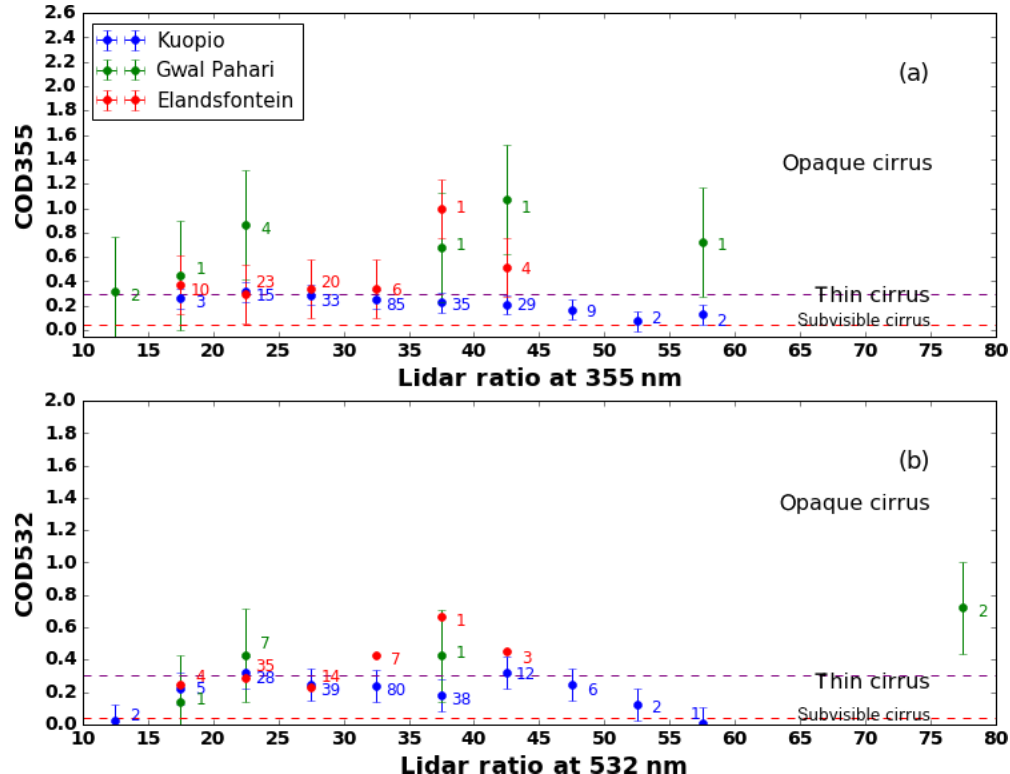
Figure 6. Dependence of the lidar ratio on COD at 355nm (a) and the lidar ratio with COD at 532nm (b) . Numbers labelled indicate the number of cases per lidar ratio bin. Horizontal dashed lines: cirrus categories by Sassen and Cho (1992). Table 4. Predominant aerosol type and AOD FT for the three